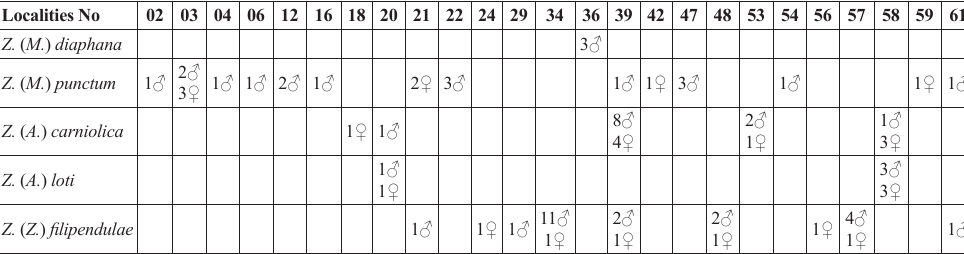
Table 3. Zygaeninae species caught in the Thrace Region in 2016. Localities